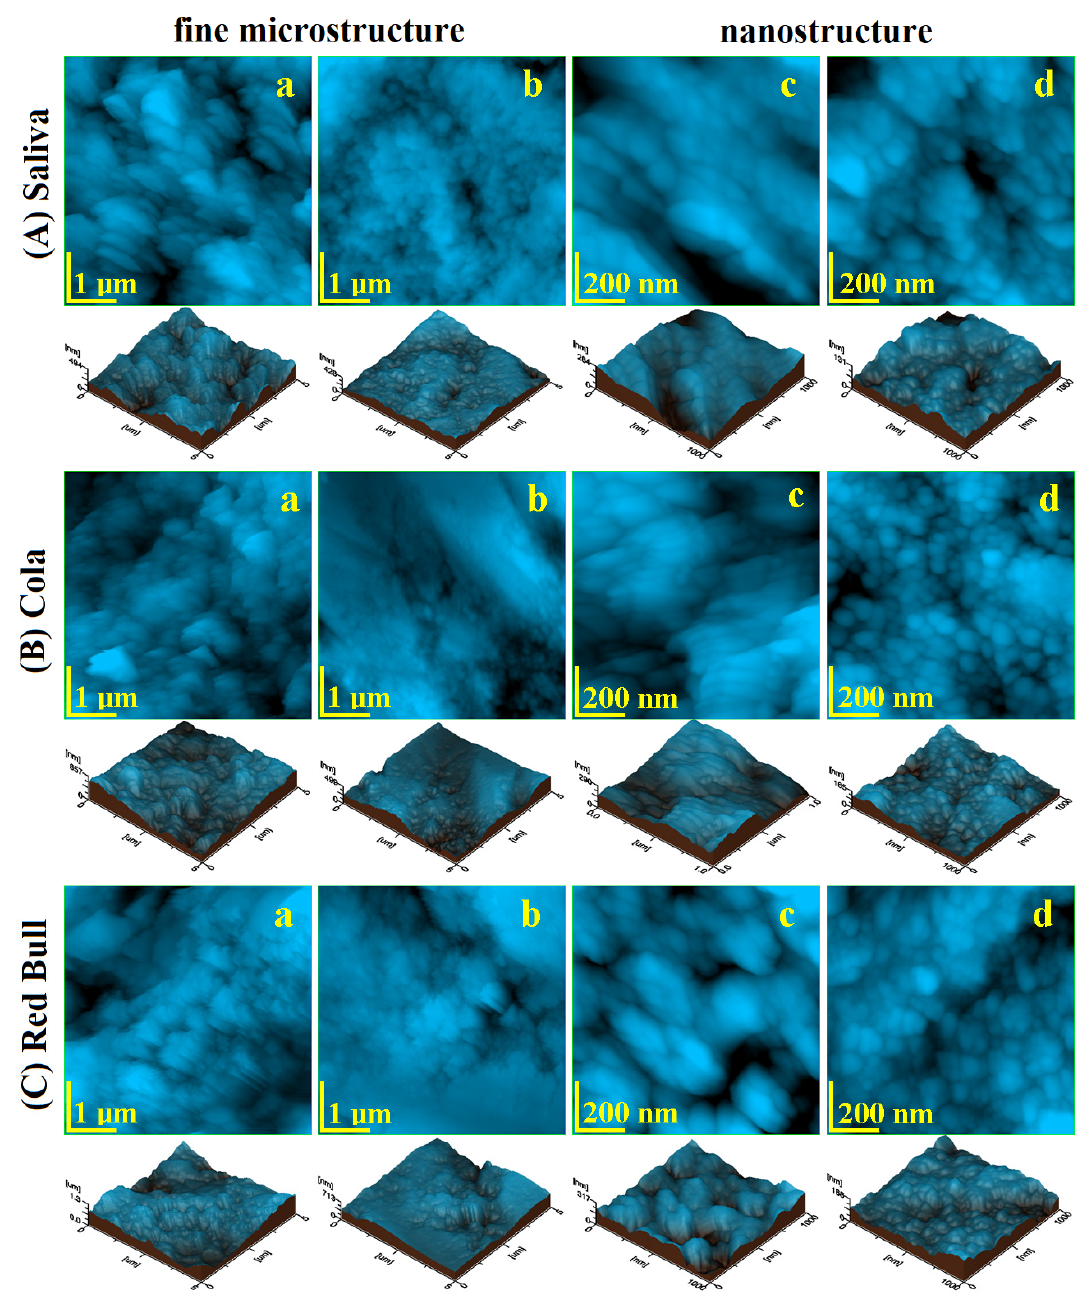
Figure 5. AFM imaging of enamel after RMGIC debonding: fine microstructure before polishing ( a ) and after polishing ( b ); nanostructure before polishing ( c ) and after polishing ( d ); stored in Saliva ( A ), exposed to Cola ( B ), and exposed to Red Bull TM ( C ).